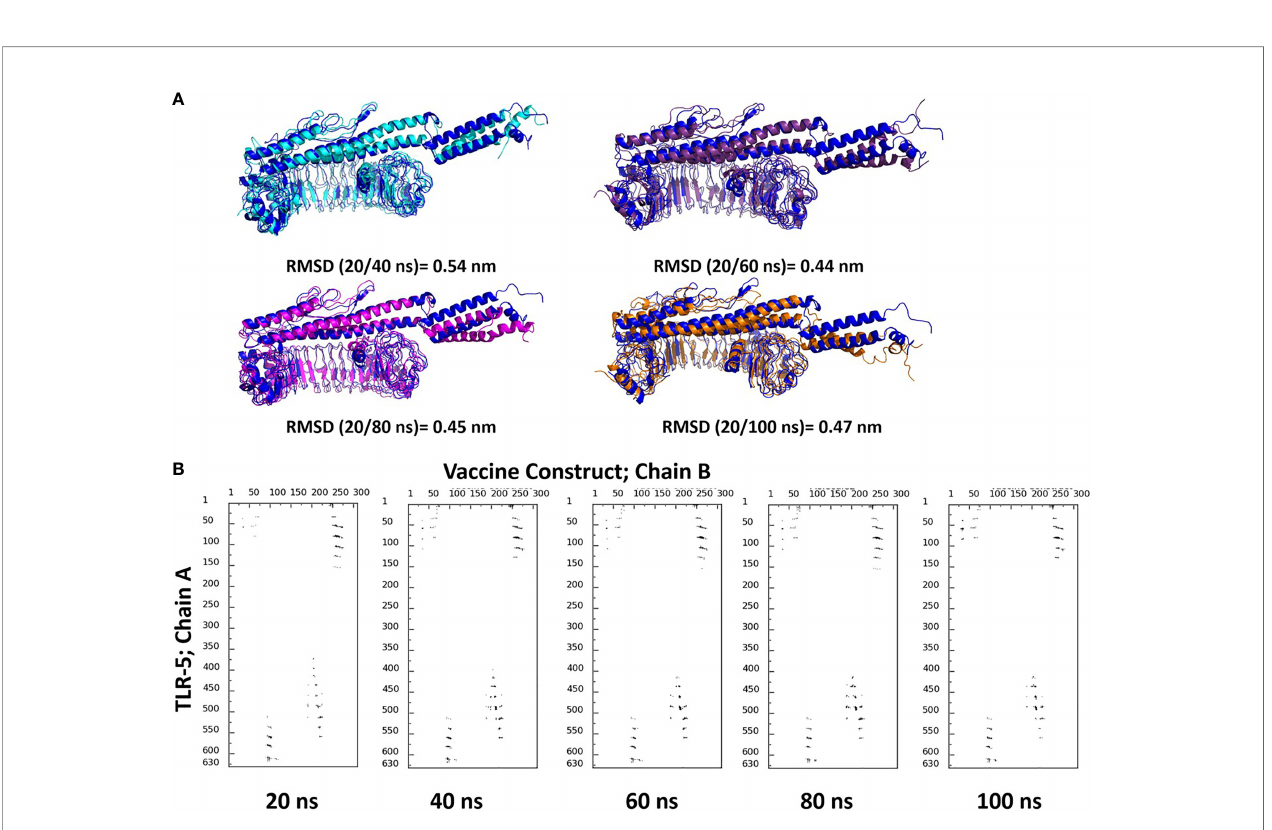
FIGURE 5 | (A) Superimposition of selected snapshots of TLR-5 and vaccine construct and their respective RMSD values are also reported; (B) Contact maps showing the conservation of contacts between residues in between TLR-5 and Vaccine